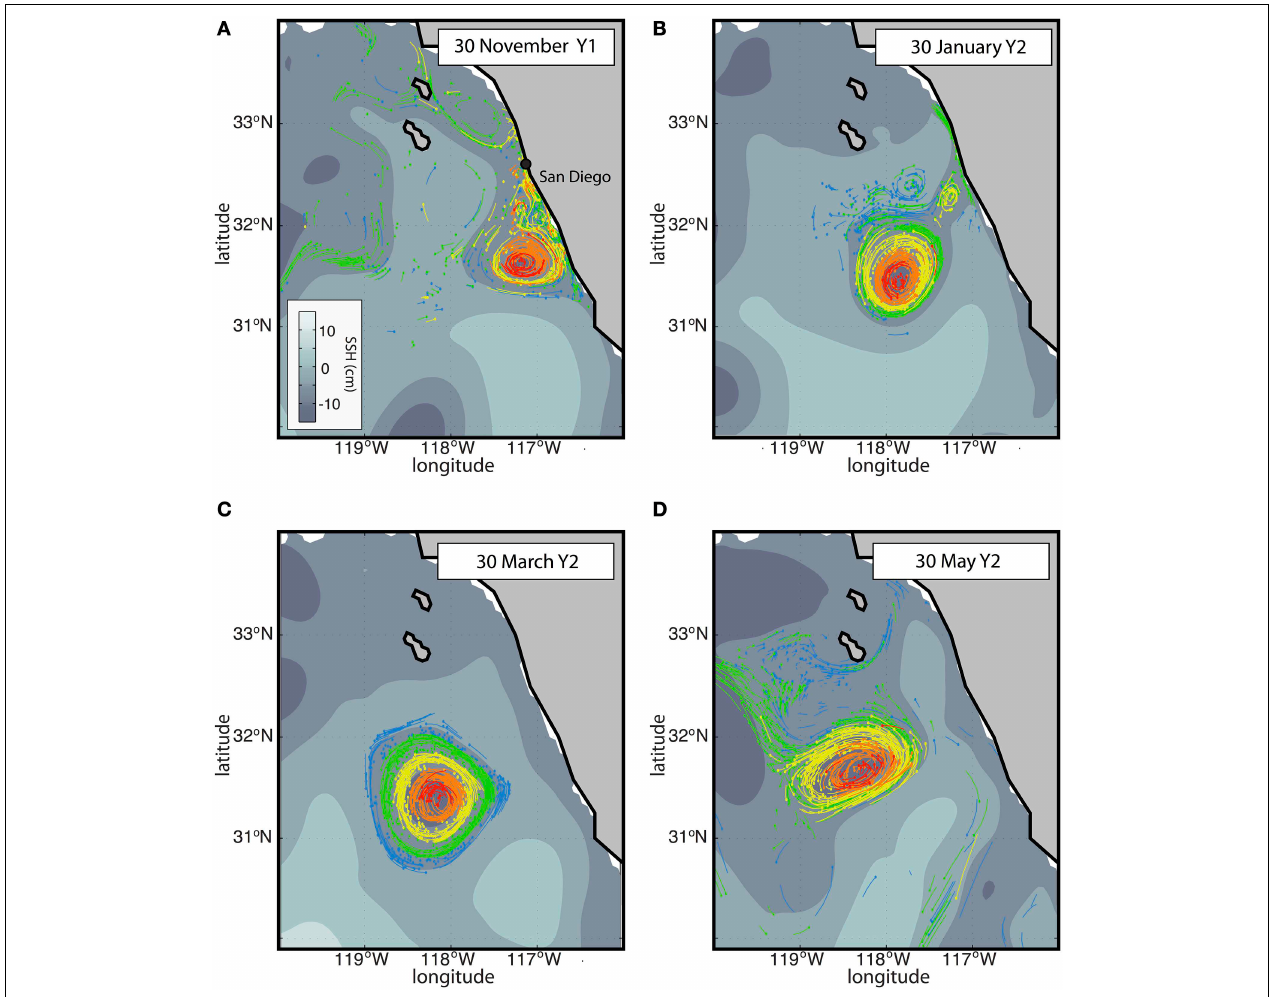
orange particles, experiencing solid body rotation during the eddy lifetime (Chenillat et al., submitted ms. a). The trajectories during the 3 days prior to each date are drawn with thin colored lines (to keep the figure clear, only half of them are represented). The particles on display are those trapped within the eddy on 30 March Y2 (C) , tracked either backward (A,B) or forward (D) in time (see Figure 6